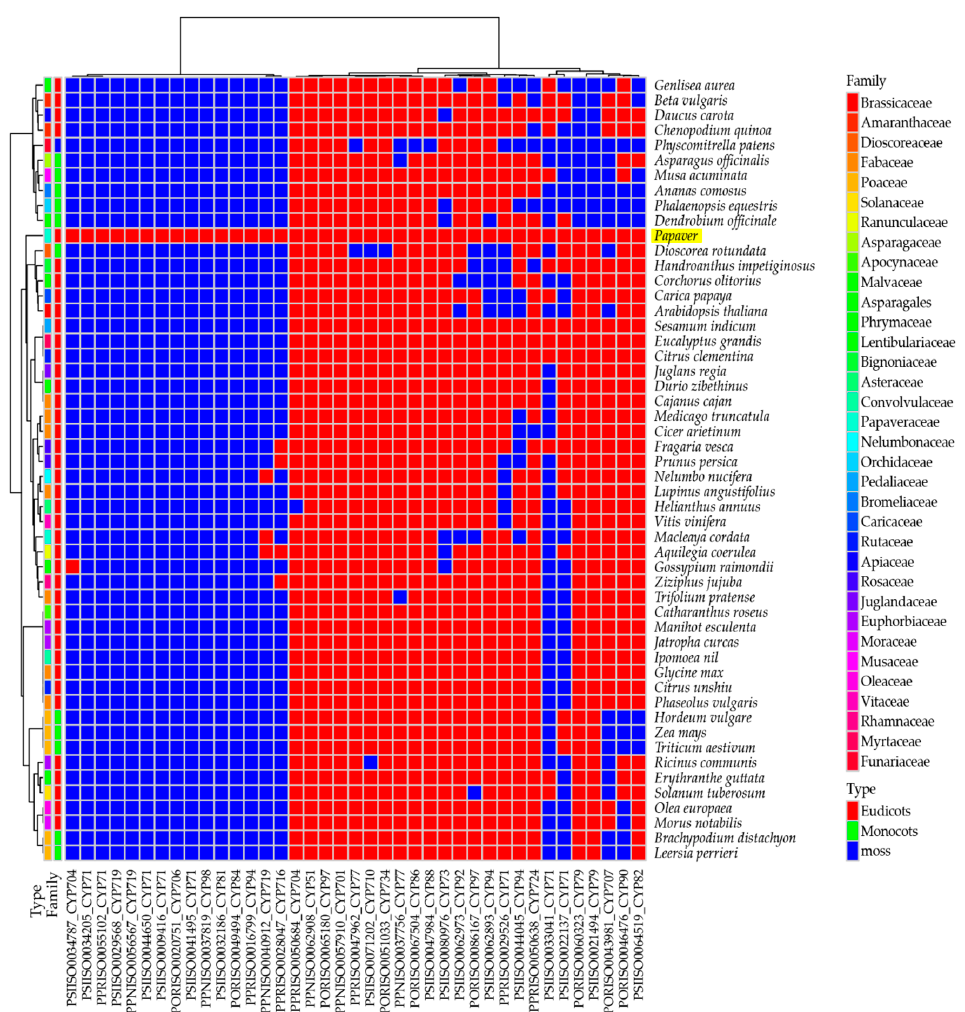
Figure 9. Full-length cytochrome existence profile. The expression of the heat map is shown in red (transcripts present) and blue (transcripts absent), this information obtained from the ortholog clusters.